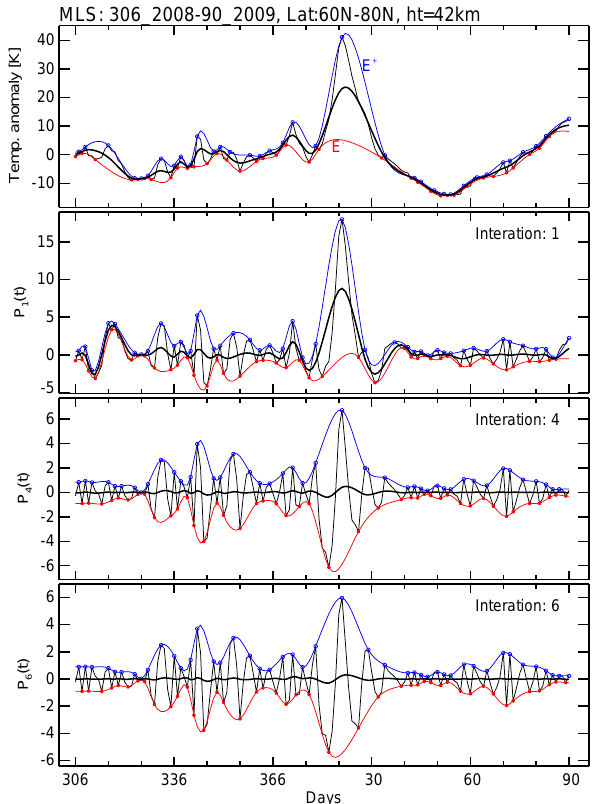
Fig. 3. Procedure showing the extraction of first intrinsic mode function (IMF) from MLS temperature anomaly over latitude 60– 80 ◦ N at 42km altitude level during November 2008 to March 2009. See text for